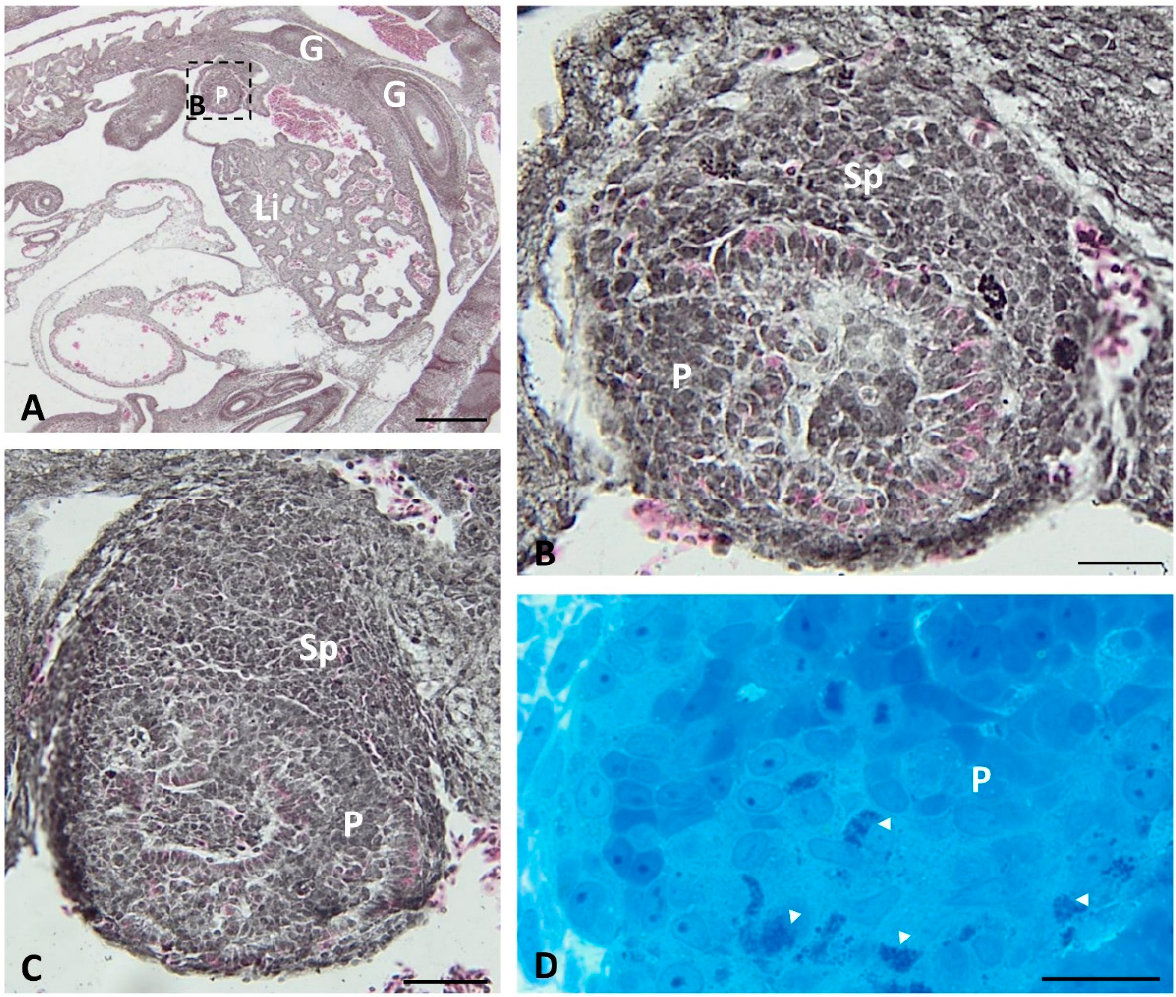
Figure 1. Transverse sections through the grass snake embryo body ( A ) and pancreas ( B – D ) at developmental stages I–III. ( A – C ) Sections stained with phloxine and gallocyanin. ( A ) Scale bar = 100 µ m. ( B ) Magnification of the frame in ( A ). ( B , C ) Note agglomerations of endocrine cells near the spleen anlage. Scale bar = 20 µ m. ( D ) Section stained with methylene blue. Scale bar = 20 µ m Abbreviations: G: gut; Li: liver; P: pancreas; Sp: spleen; arrowhead—endocrine cell.